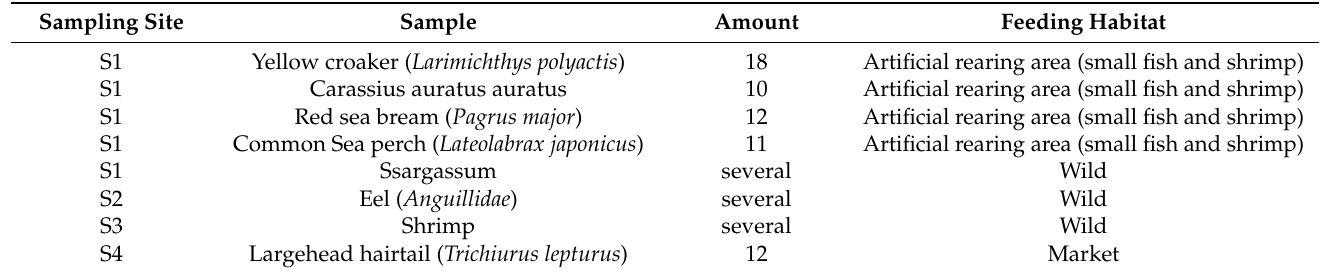
Table 1. Sampling sites, corresponding samples, and feeding